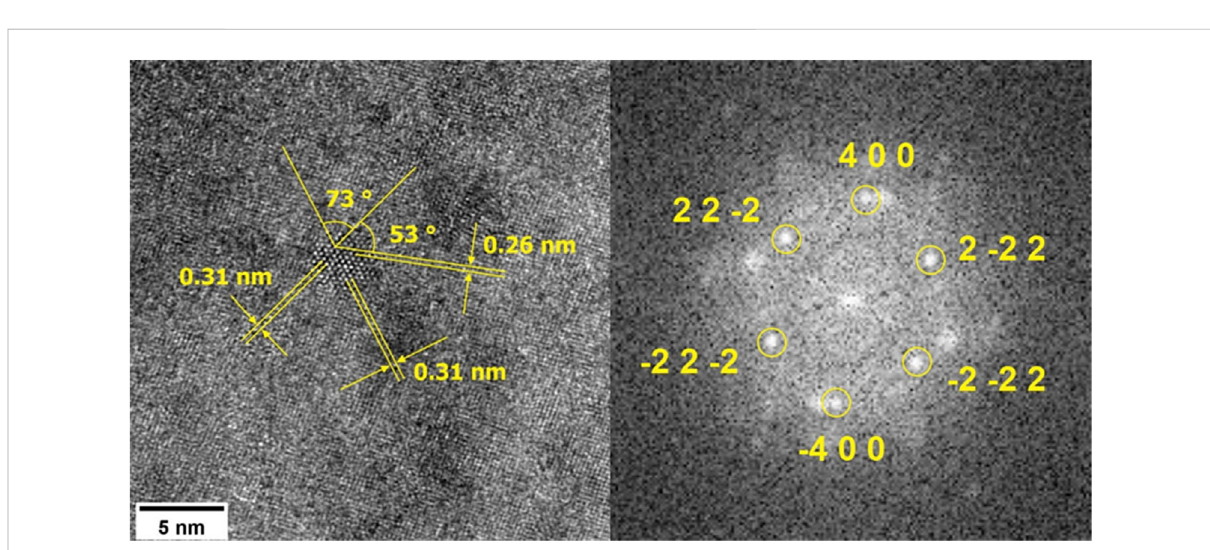
FIGURE 4 TEM image of an oxide nano-precipitate with a diameter of 3.5 nm together with its fast Fourier transform (FFT) image, showing a structure of Y